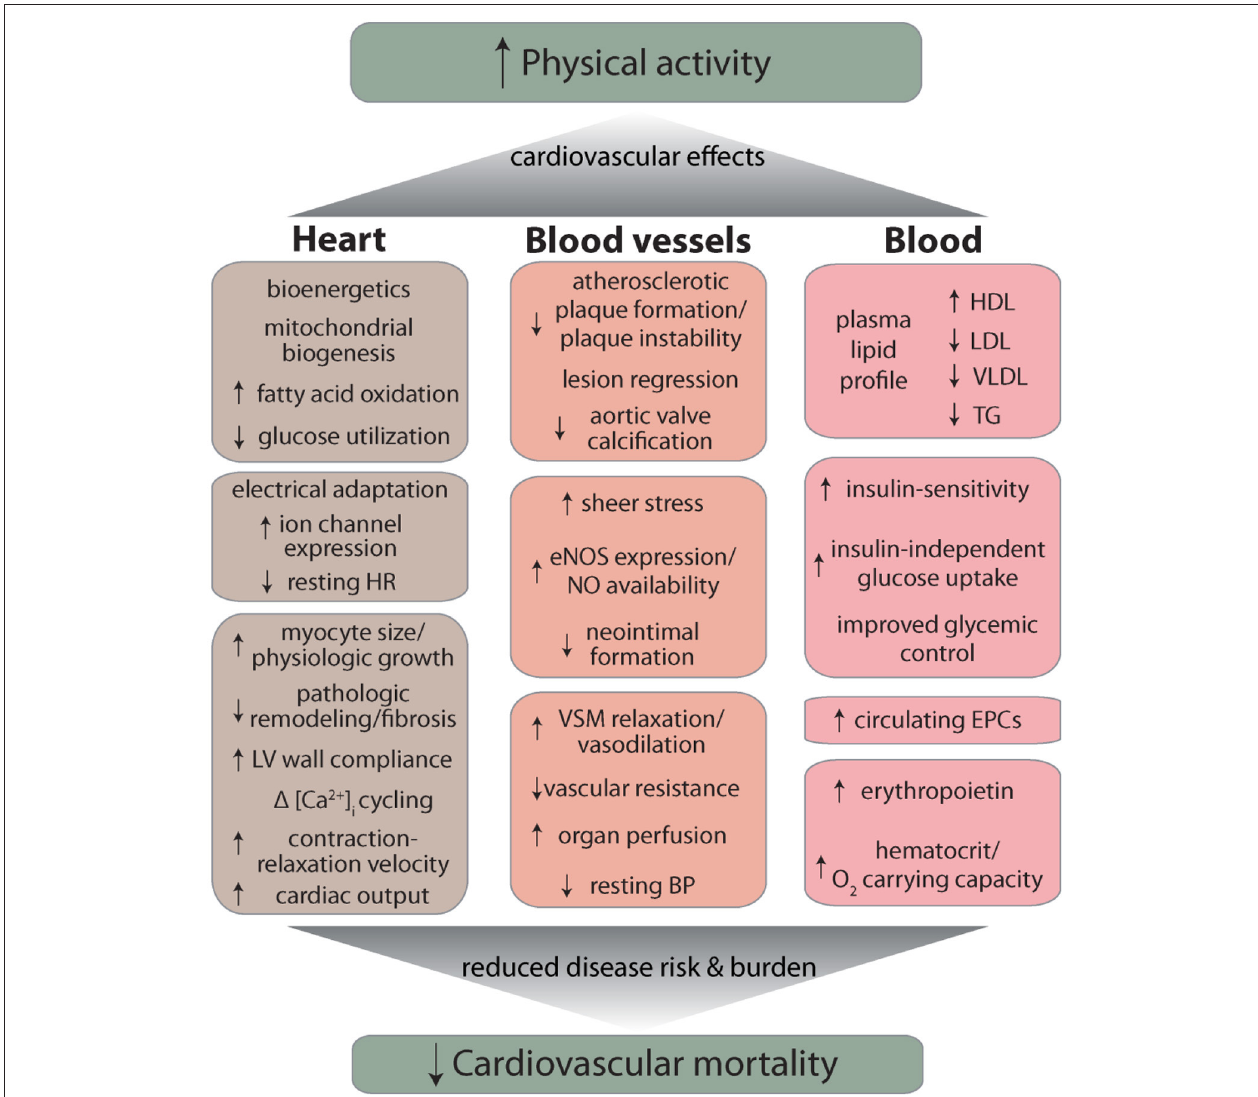
FIGURE 1 | Overview of major cardiovascular effects of exercise. Abbreviations: HR, heart rate; LV, left ventricle; eNOS, endothelial nitric oxide synthase; NO, nitric oxide; VSM, vascular smooth muscle; BP, blood pressure; HDL, high density lipoprotein; LDL, low density lipoprotein; VLDL, very low density lipoprotein; TG, triglycerides; EPC, endothelial progenitor